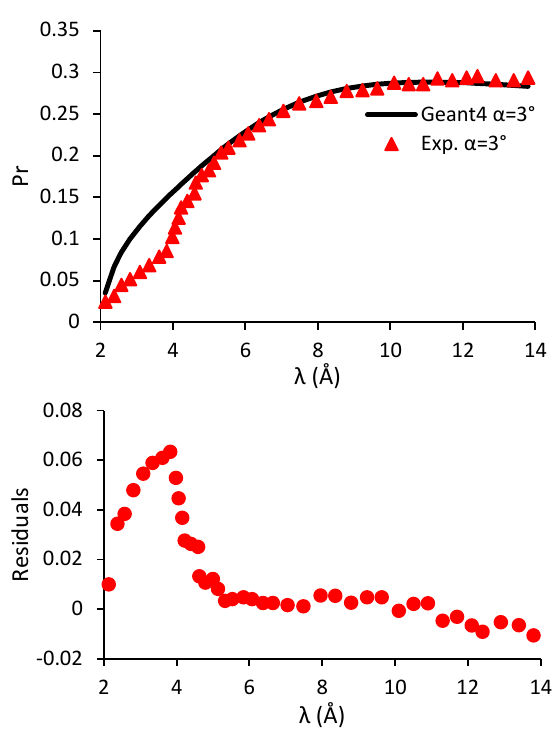
Fig. 7. Simulation of neutron transmission of nanodiamonds in Geant4.